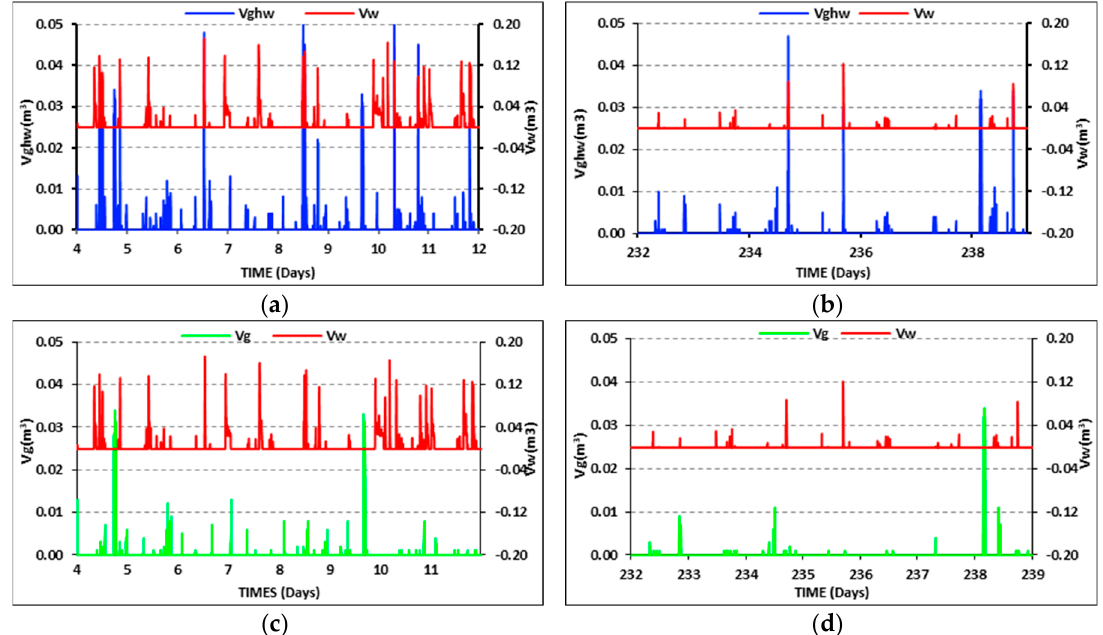
radiation, December 2014; ( c ) P PV meter vs. radiation, 2014 (all year).